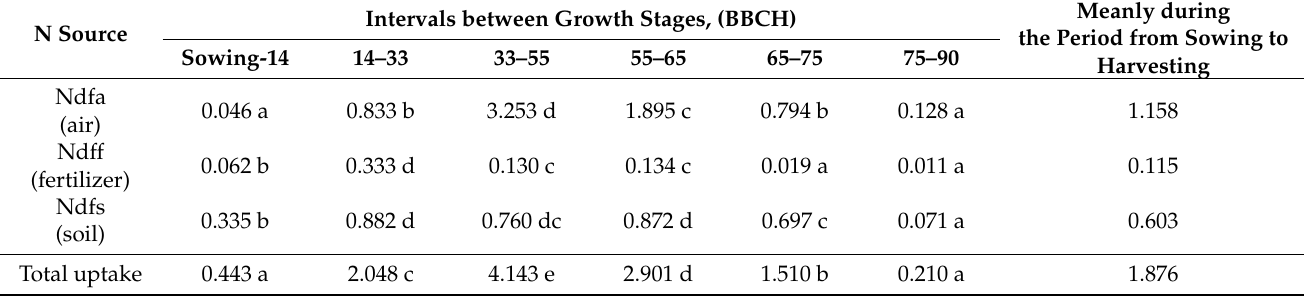
Table 9. Amount of nitrogen taken up by pea (whole plant) from various sources per day during the period from sowing to harvest, kg N · ha − 1 .